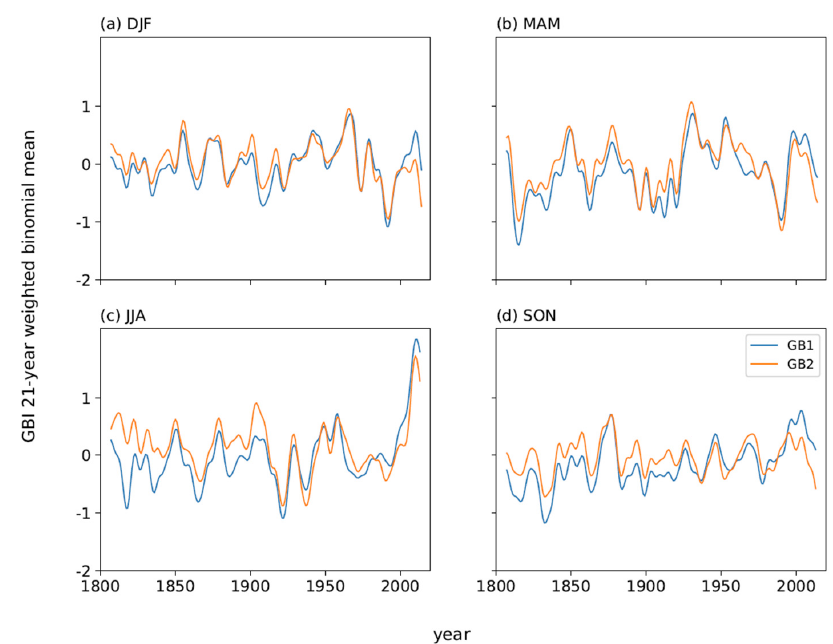
Figure 5. Smoothed seasonal series of GB 1 and GB 2 for ( a ) winter (DJF), ( b ) spring (MAM), ( c ) summer (JJA) and ( d ) autumn (SON). GBI yearly values have here been filtered using a 21-point binomial filter to emphasize any long-term fluctuations and trends.